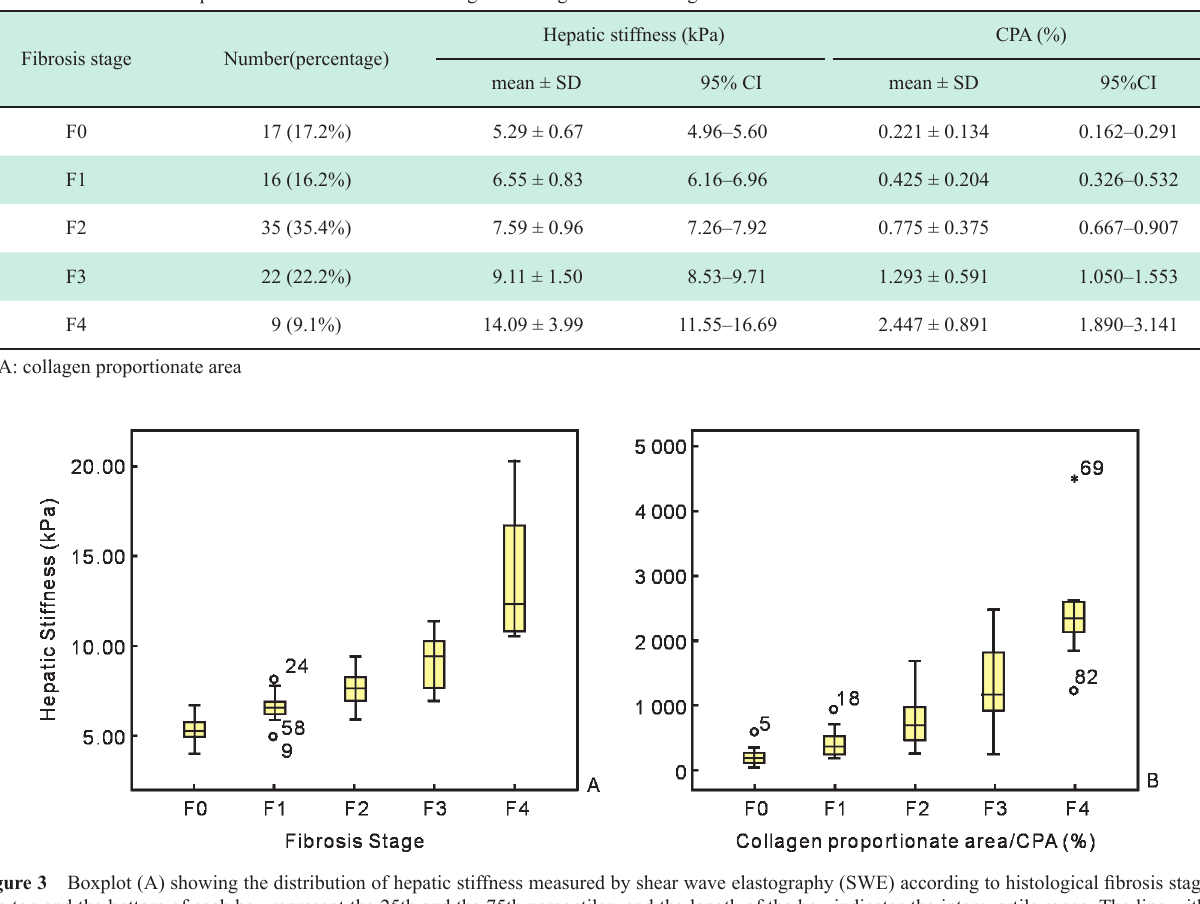
Table 1 Distribution of hepatic stiffness and CPAs according to histological fibrosis stages